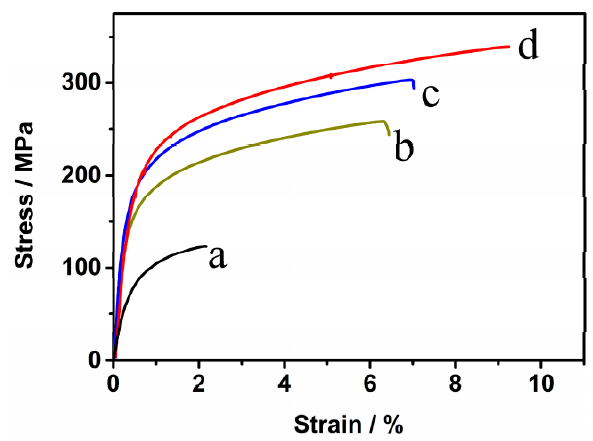
Figure 10. Tensile stress-strain curves of the MM Fe-28Mn-3Si compacts sintered at 1200 °C for various isothermal holding times: ( a ) no isothermal holding; ( b ) 1 h; ( c ) 2 h; and ( d ) 3 h. Table 2. Average static tensile properties of Fe-Mn-Si alloys sintered at 1200 °C for different isothermal holding times.